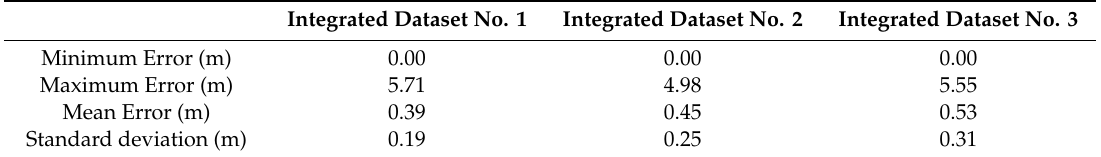
Table 7. Error values: analysis of the resulting surfaces compared to the reference surface for the LNG port